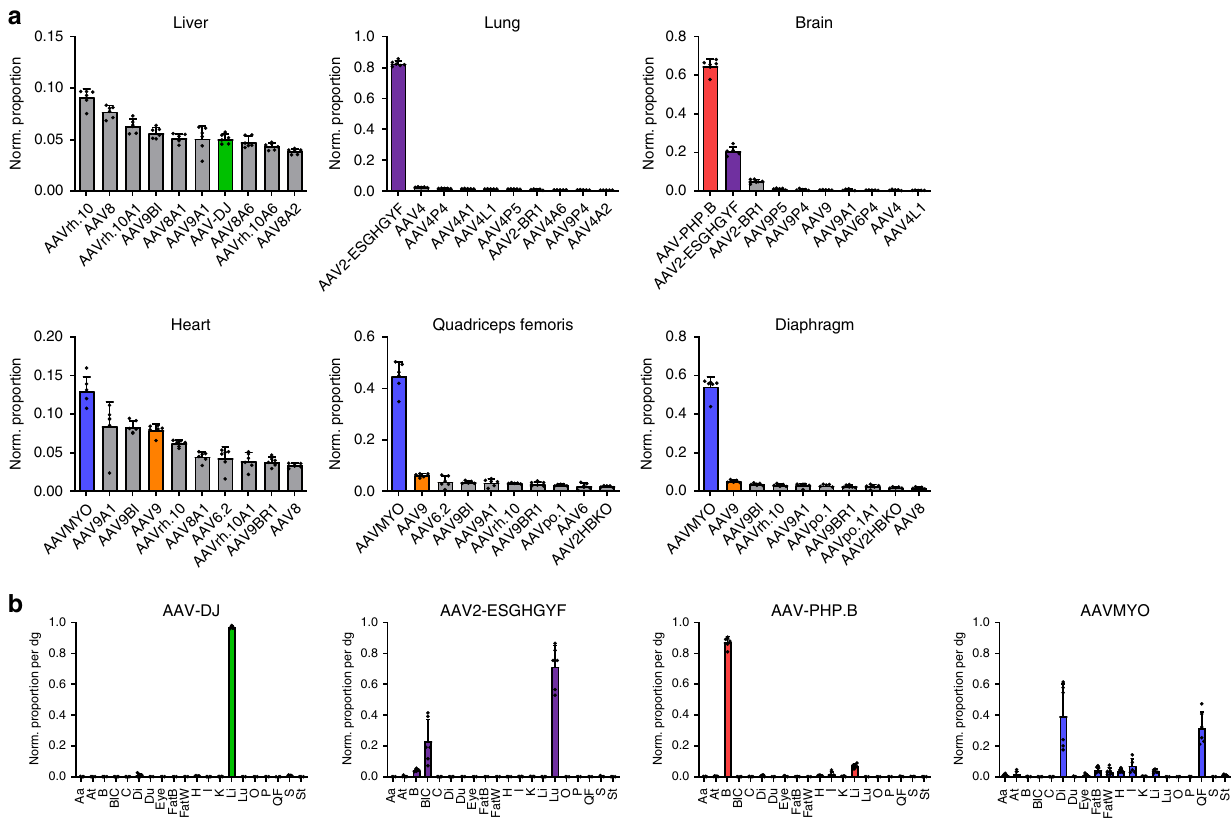
Fig. 2 Examples for robust capsids in the liver, lung, brain, and musculature. a Top 10 AAV variants in the second library and the shown tissues based on normalized transcriptional ef fi ciency ( V αβ ). Depicted values are the average from six C57BL/6J mice with SD. b Transcriptional speci fi city ( T αβ ) of the shown four capsids as normalized proportion per cell (diploid genome, dg) in abdominal aorta (Aa), thoracic aorta (At), brain (B), blood cells (BlC), colon (C), diaphragm (Di), duodenum (Du), eye, brown fat (FatB), white fat (FatW), heart (H), inner ear (I), kidney (K), liver (Li), lung (Lu), ovaries (O), pancreas (P), quadriceps femoris (QF), spleen (S), and stomach (St). Depicted are average cDNA values from six C57BL/6 J mice with SD. Colors in a and b highlight the same capsids in both panels. Source data are available in the Source data fi